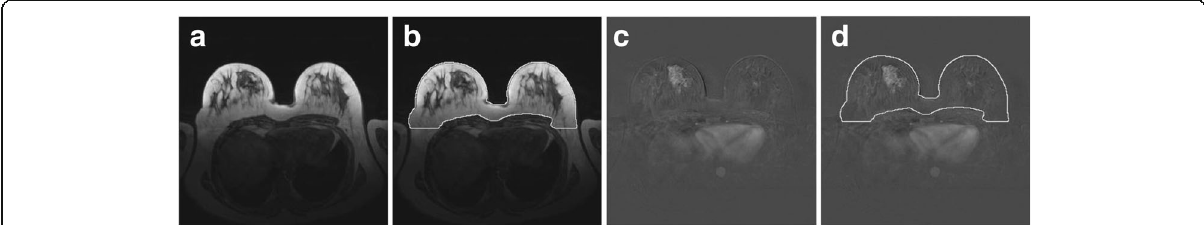
Fig. 3 Demonstration of the breast region segmentation method using sample images. a Nonfat-suppressed image. b Breast segmentation from a. c The subtracted image at the first post-contrast time point and d breast segmentation from c